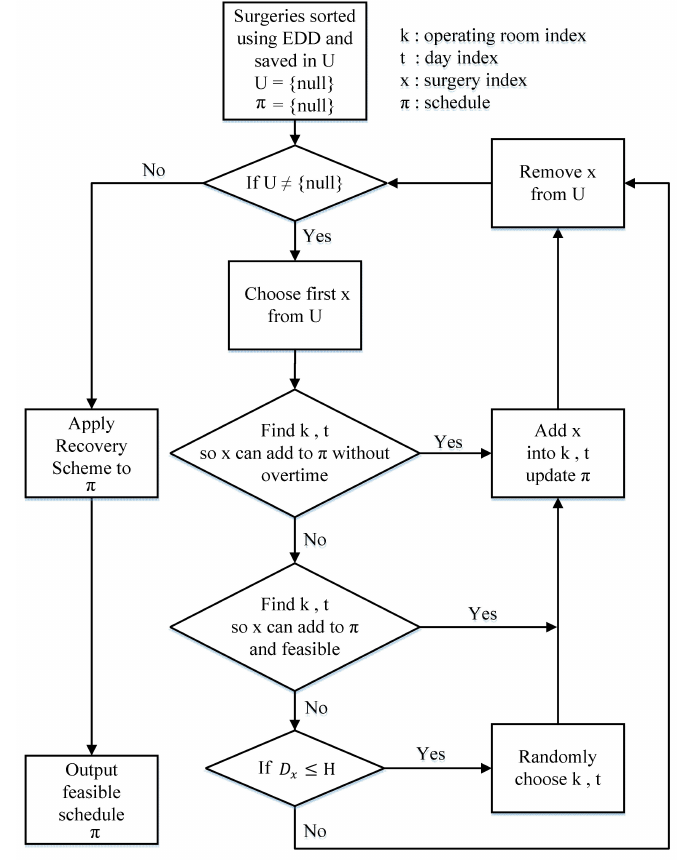
Figure 1. The flow chart of the modified earliest due date (MEDD) heuristic. MEDD